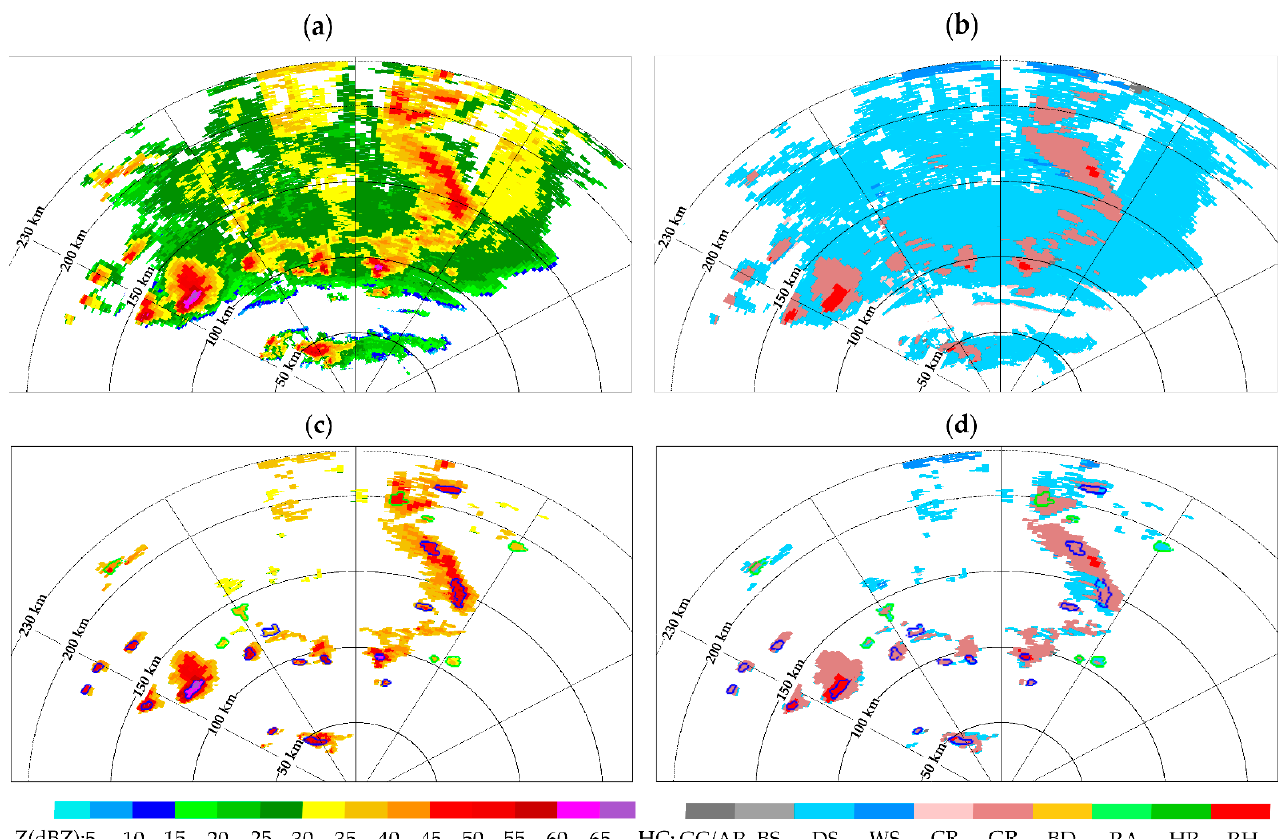
Figure 5. Illustration of differences in the hydrometeor areas in the identification results from the original SCIT and the modified SCIT at 2130 LST on 26 April 2019: ( a , c ) real and identified reflectivity areas in the 7 km altitude plane (above the melting layer); ( b , d ) real and identified hydrometeor classification areas at the 7-km altitude plane. In ( c , d ), the pixel regions identified by the modified SCIT represent the echo areas of Convective Systems 1–10 and their hydrometeor classification results, while green (blue) outlines inside the 10 convective systems indicate the boundaries of non-hail cells (hail cells) identified by the original